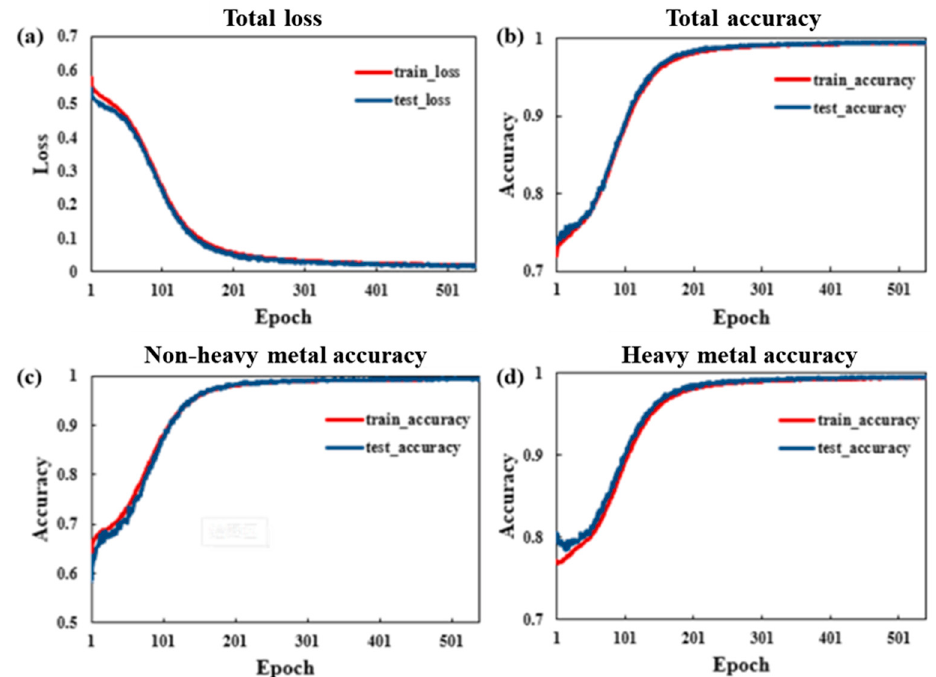
Figure 6. Accuracy and loss curves of the model ( a ): Overall Loss curve of the model. ( b ): Overall training and testing accuracy of the model. ( c ): Training and testing accuracy of non-heavy metal samples. ( d ): Training and testing accuracy of heavy metal samples.